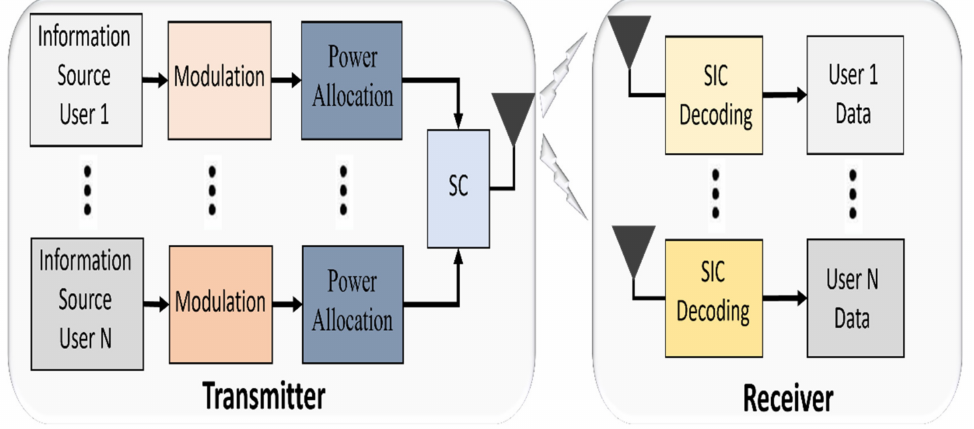
Figure 8. Block diagram of PD-NOMA in the RF